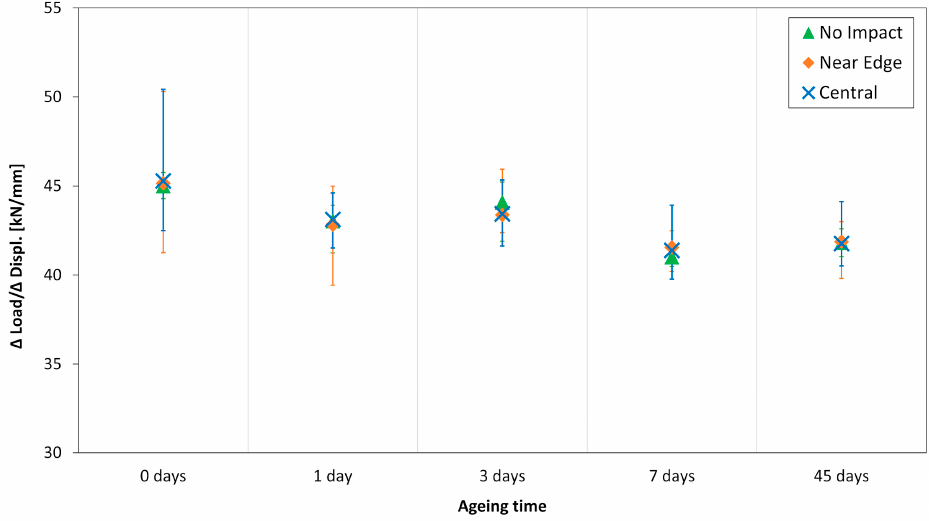
Figure 7. Specimen stiffness at different ageing times.